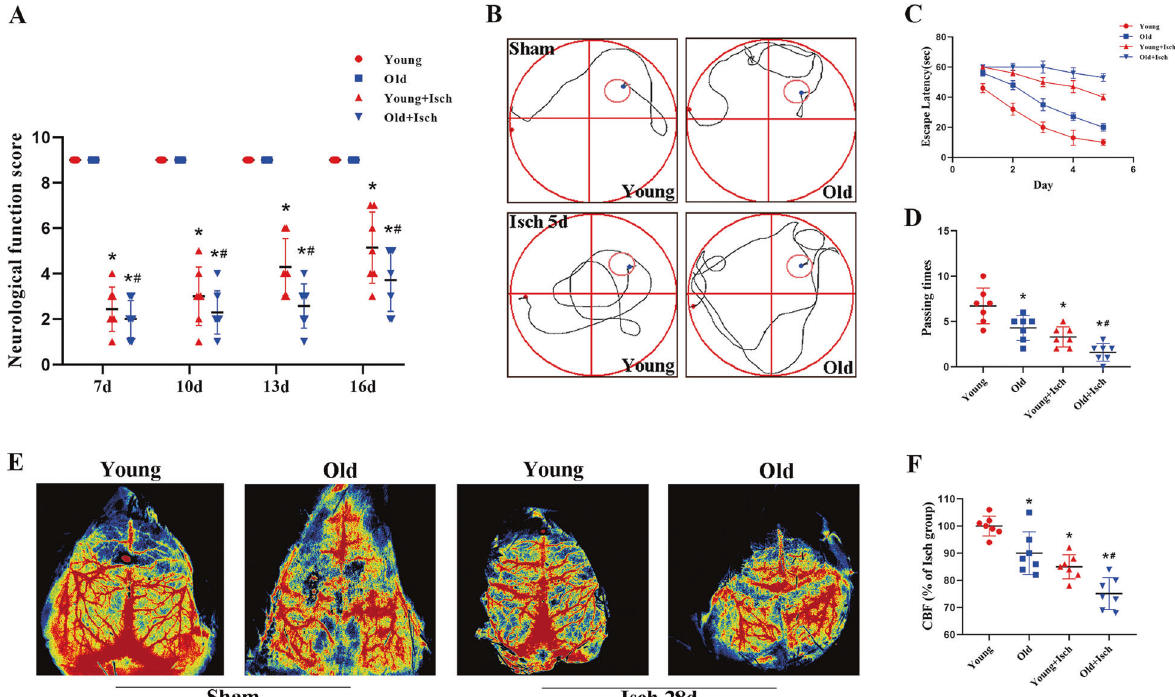
Fig. 1 Observation of neurological function and recovery. Neurological-function score of young and old gerbils after I/R ( A ). The maps of computer printouts of the swimming trajectories on the fi fth day of each group ( B ). The time spent in the removed escape-platform quadrant ( C ). Number of crossings over the original platform position by gerbils ( D ) ( n = 7 per group; * p < 0.05, signi fi cantly different from the corresponding young group, # p < 0.05, signi fi cantly different from the young I/R group). Bars indicate mean ±